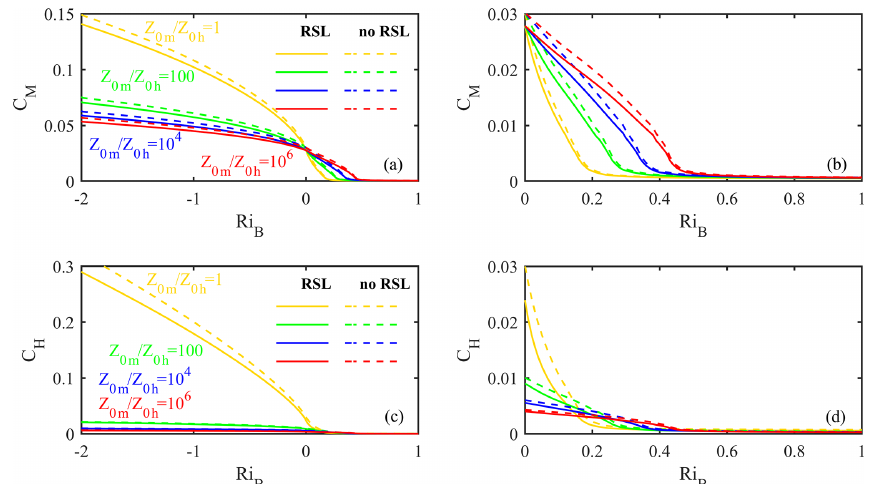
Figure 5. The relationships between C M (C H ) and Ri B under different ratios of z 0 m to z 0 h and treatments of the RSL. Solid lines: considering the RSL effect; dotted lines: without the RSL